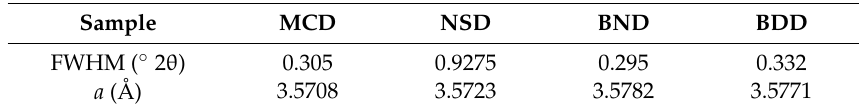
Figure 2. Observed and fitted profile for (111) Bragg diffraction peak for cubic diamond for MCD, NSD, and BND films. Table 1. Measured values for FWHM (Full Width at Half Maximum) of diamond (111) Bragg X-ray peak and lattice parameter “ a ” in Angstrom for cubic diamond.